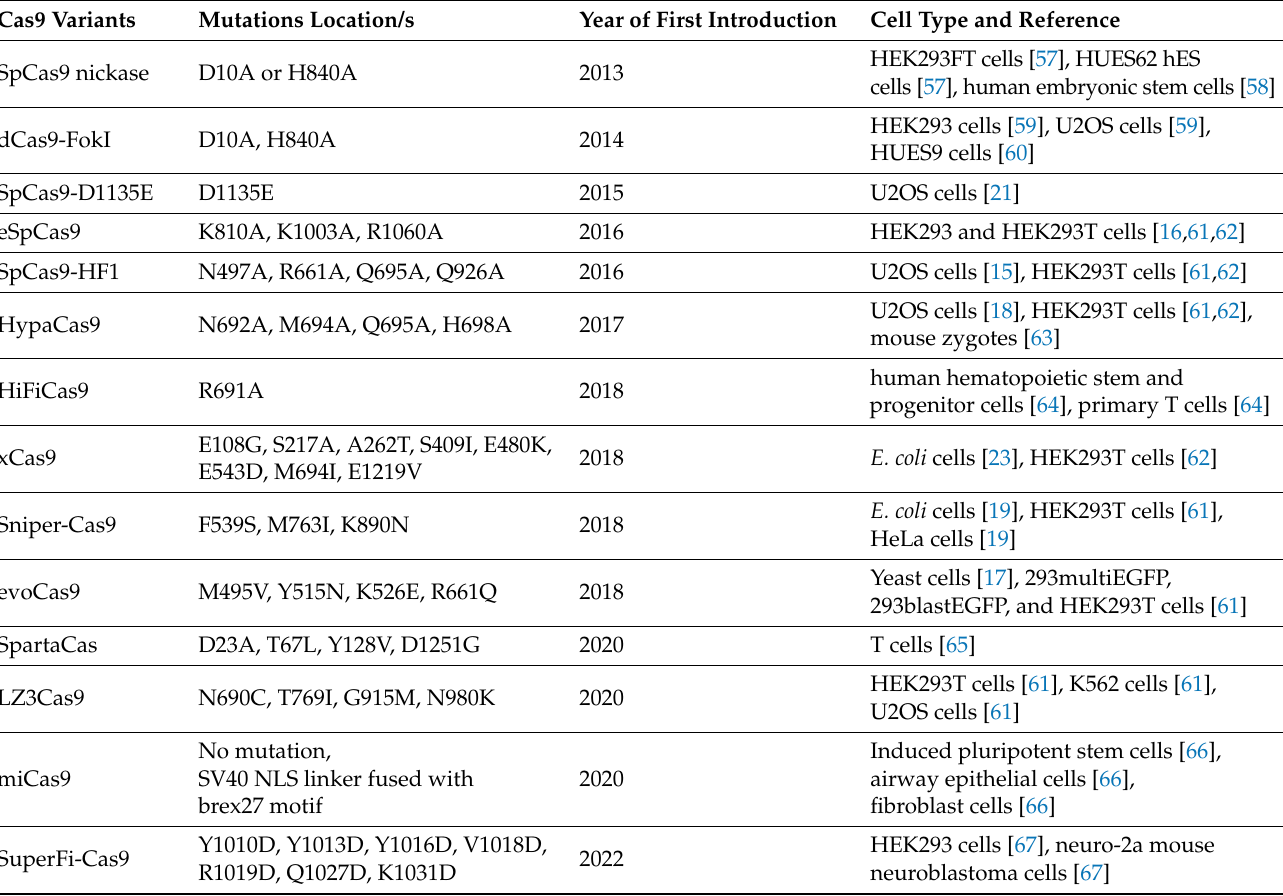
Table 1. Summary of SpCas9 variants with mutation locations studied in different cell